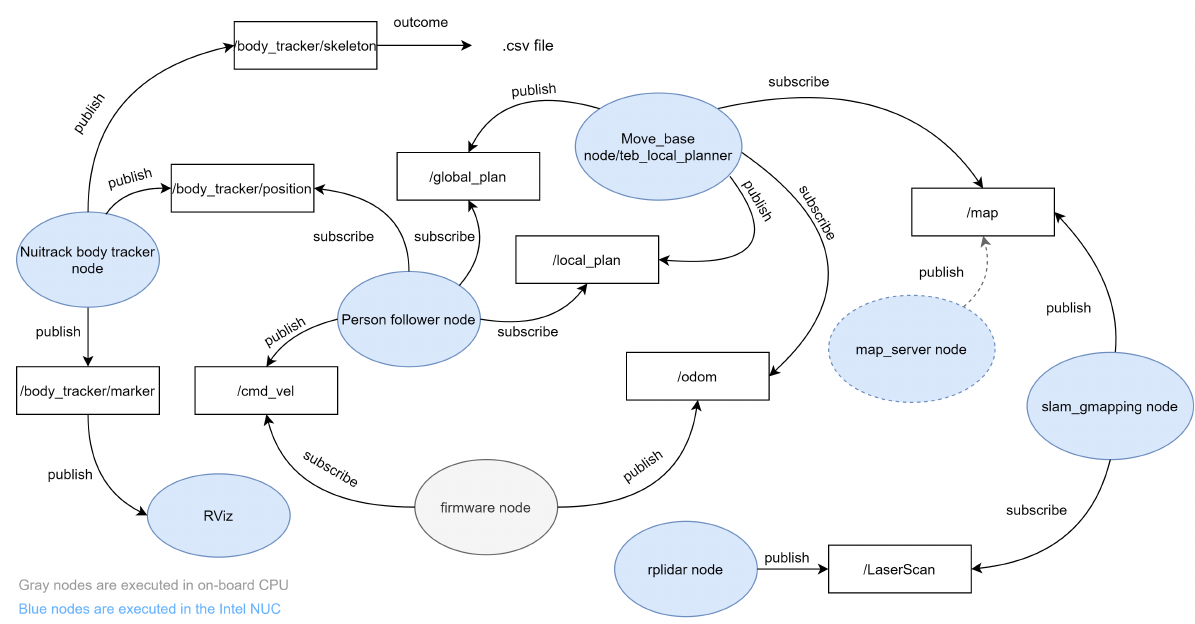
Figure 3. Data flow in the mobile robotic platform following the ROS publisher/subscriber communication